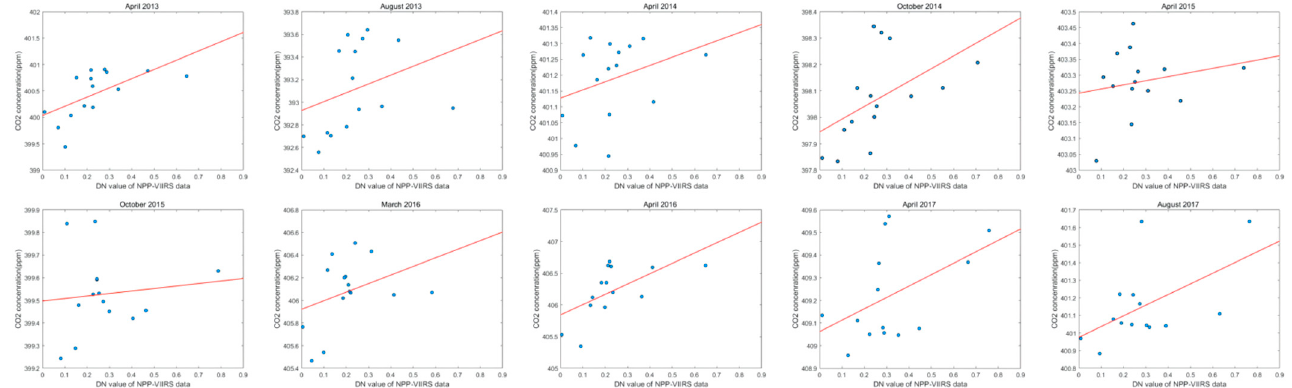
Figure A2. Correlation between monthly NL data and CO 2 concentration of cities in Hubei province from 2013 to 2017.